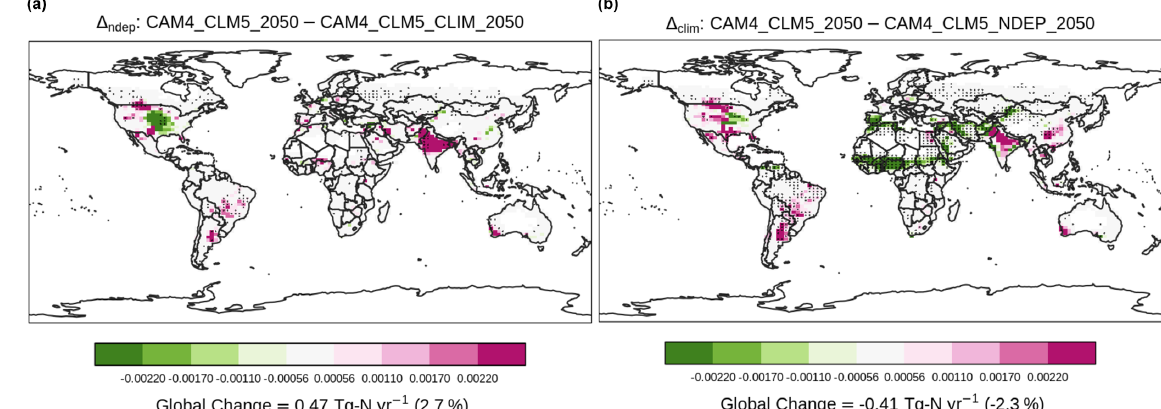
Figure 7. Contrasting the difference in NH 3 emission (TgNyr − 1 ) . Overlaying black dots indicate grid cells with a statistically significant difference under two-sample t tests (i.e., p < 0 . 05) between corresponding simulations. Only results of grid cells with croplands are shown.